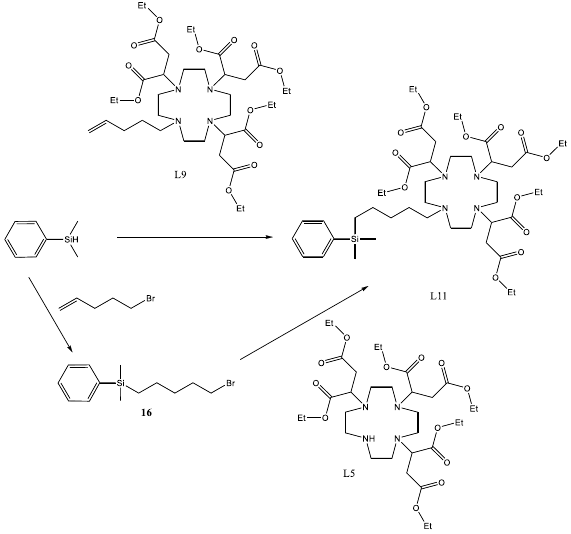
Scheme 3. Routes to the synthesis of L11 via cyclen intermediates.